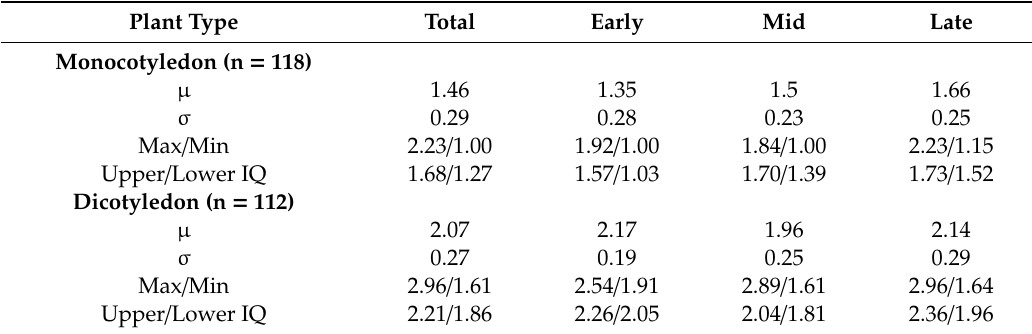
Table 2. Summary of leaf structure parameter ( N s ) metrics 1